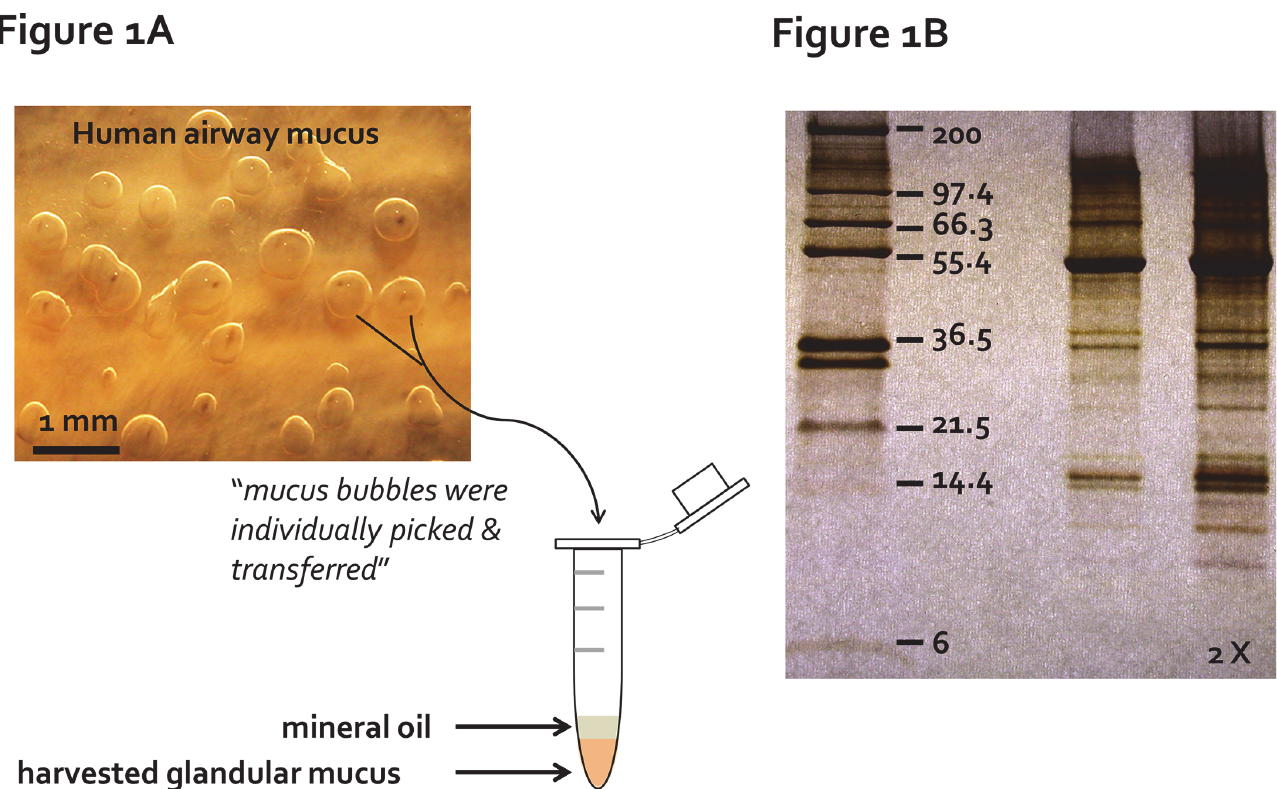
Fig 1. Primary pure human gland mucus collection. (A) Individual gland mucus bubbles, stimulated by a combination of 10 μ M carbachol and 10 μ M forskolin, formed under the water-saturated mineral oil on the tracheal mucosa, were picked up with sterilized microforceps and transferred into a sterilized Eppendorf tube for proteomics analysis. (B) A representative image of silver-stained protein bands from a human gland mucus sample collected as (A) on a Tris-Tricine 4 – 20% SDS polyacrylamide gradient gel. Protein molecular weight standard are shown on the left lane of the gel. Twice the same sample volumes were loaded on the far right